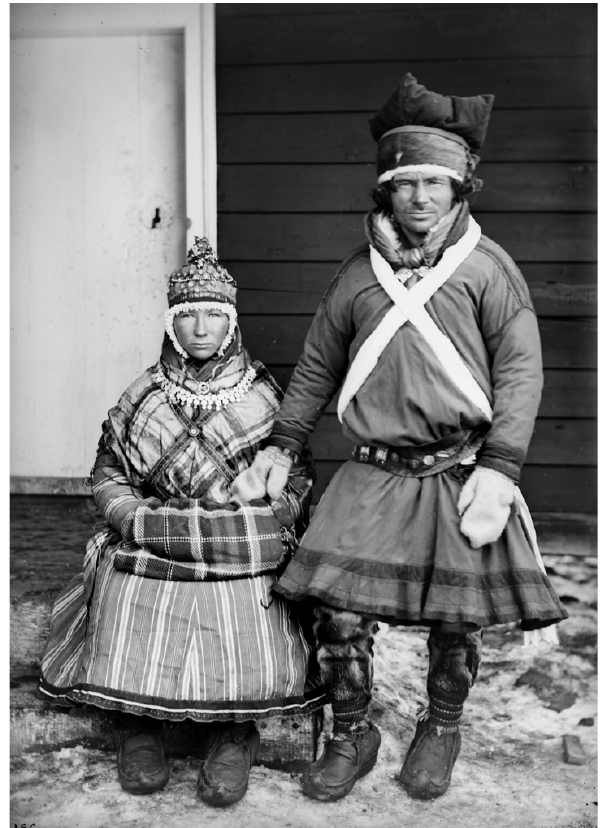
Figure 6. Sami bride and groom (Tromholt, photo from UBB col-